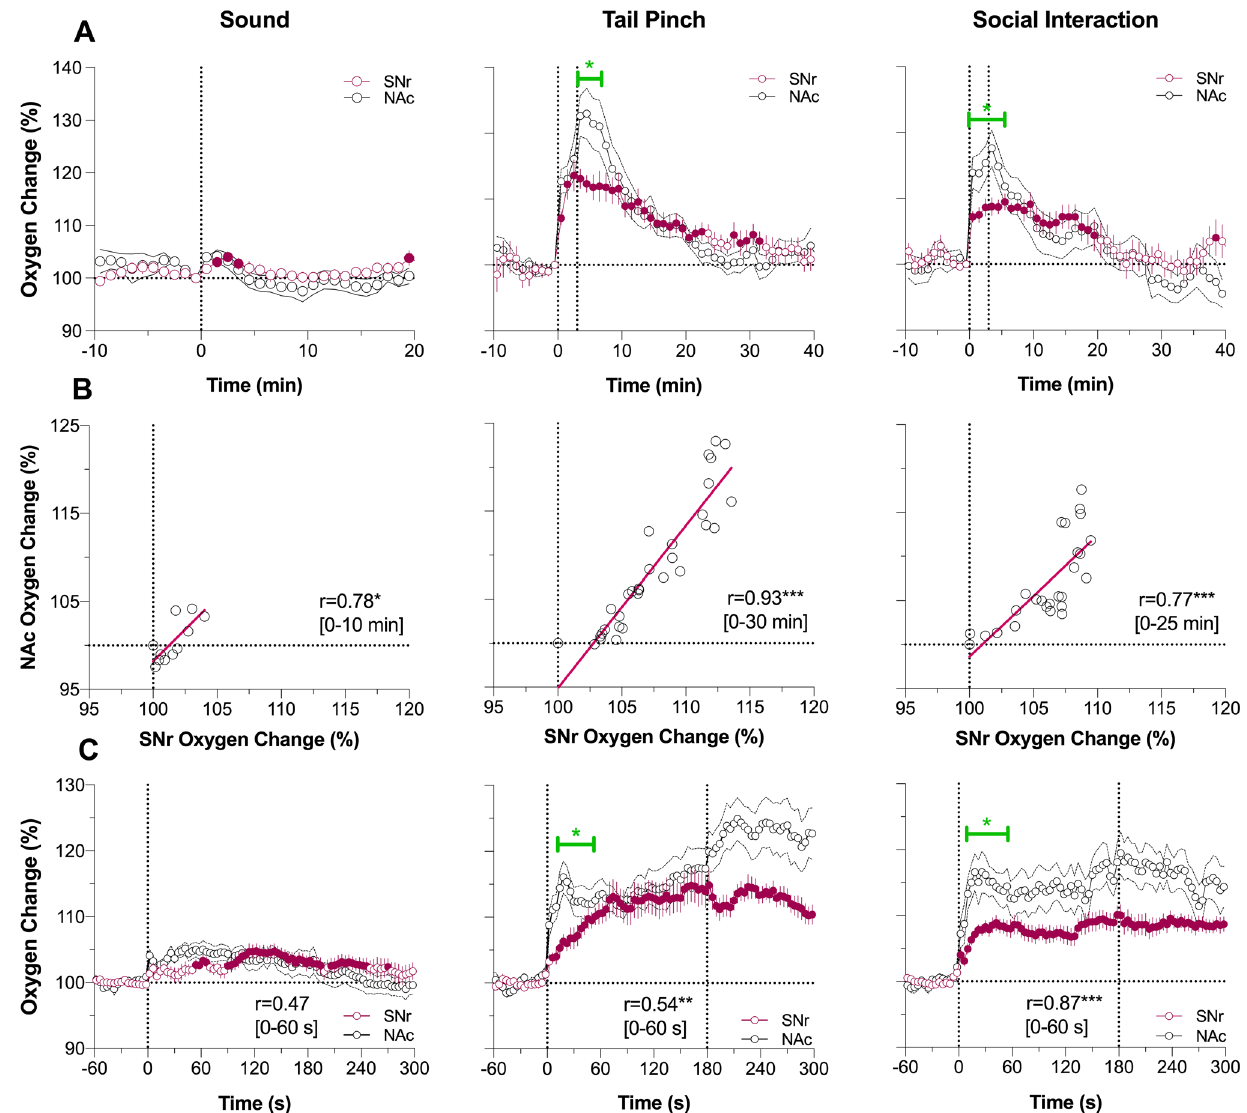
Figure 5. Changes in oxygen levels in substantia nigra, pars reticulata (SNr) induced by auditory stimulus (Sound), Tail-pinch and Social Interaction in awake, freely moving rats. Comparison with nucleus accumbens (NAc) responses. ( A ) Mean (± SEM) changes in oxygen levels relative to baseline (100%) calculated with 1-min time bins. Vertical hatched lines show onset and offset of stimulus presentation. Filled symbols mark values significantly different from pre-stimulus baseline ( P < 0.05). ( B ) Correlative relationships between oxygen changes in two recording locations. r = coefficient of correlation calculated for the time interval of significant increase in NAc oxygen levels (values in brackets). ( C ) Mean (± SEM) changes in oxygen levels relative to baseline (100%) calculated with 4-s time bins. SNr data were obtained in 4 rats; 12, 9 and 9 responses were averaged for cocaine and heroin at two doses, respectively) (see Supplementary materials for ANOVA values and n in each group). Asterisks show significance of coefficients of correlation (*, ** and ***, P < 0.05, P < 0.01 and 0.001, respectively). Green line with asterisk shows significant between-structure differences in oxygen curves for the initial period following stimulus Supplemental Materials). However, in one rat, the sensor’s tip was located more laterally (“core”). To exam- ine whether the recording location may affect the pattern of the oxygen response, we analyzed mean oxygen responses, induced by tail-pinch in each of the six rats of this group (see Figure S1B in Supplementary Materi- als). This analysis revealed that while there was some between-animal variability, there was a similar pattern in oxygen increase for all six animals. Importantly, the rat with a more lateral sensor location demonstrated an oxygen increase well within the variability of this group. Although SNr was our intendent target in the second experiment, in one of four rats, the sensor tip was located more dorsally at the upper border of the SNr, closer to SN pars compacta and parabrachial nucleus (see Fig. S1C in Supplementary Materials). Similar to that in the NAc sample, tail-pinch-induced oxygen increase showed significant variability, but the pattern of oxygen response in the rat with more dorsal sensor location did not differ from that in other rats of this group (see Fig. S1D).